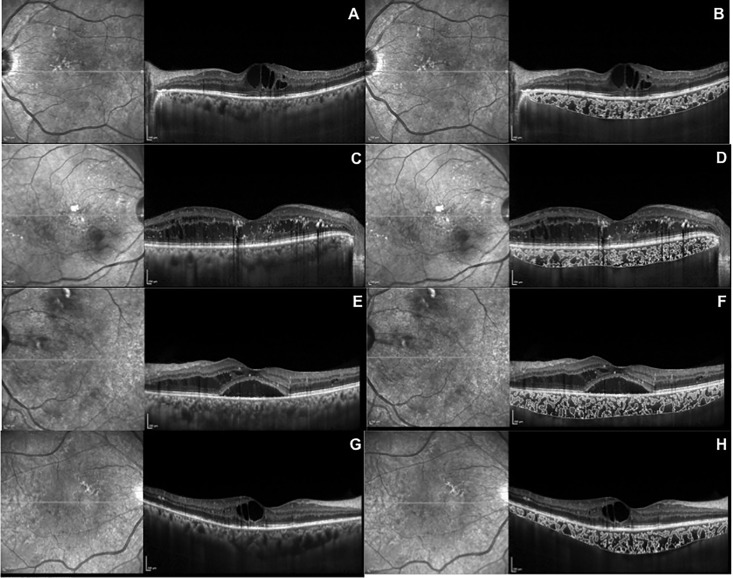
Image binarization of EDI OCT scans.A- Non segmented scan of patient with mild non proliferative diabetic retinopathy (NPDR); B- Segmented scan of patient with mild non NPDR. C- Non segmented scan of patient with moderate NPDR; D- segmented scan of patient with moderate NPDR; E- Non segmented scan of patient with severe NPDR; F- segmented scan of patient with severe NPDR; G- Non segmented scan of patient with proliferative diabetic retinopathy (PDR); H- Segmented scan of patient with PDR.